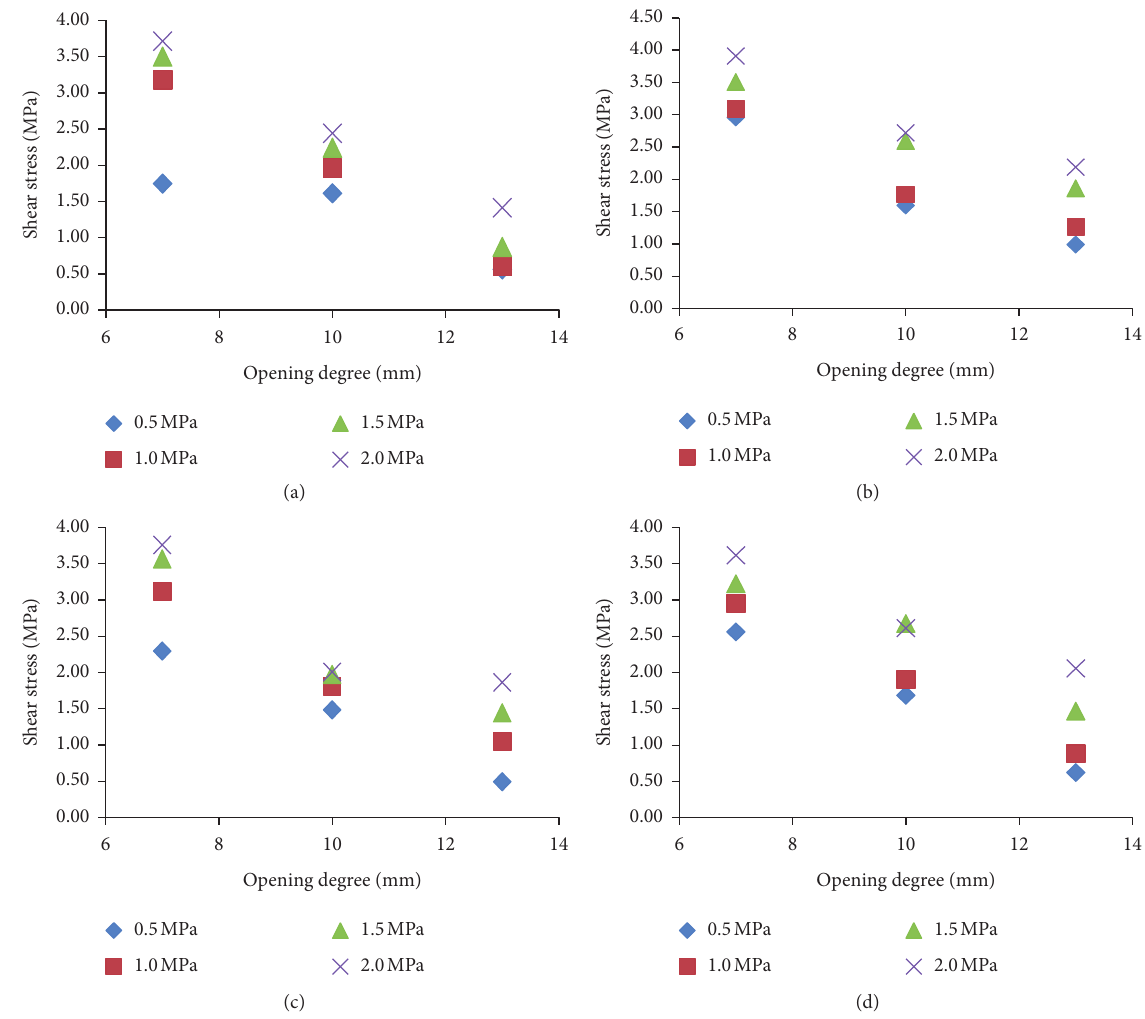
Figure 13: Evolution of peak shear strength of frozen joints under different conditions. (a) Specimen 1#. (b) Specimen 2#. (c) Specimen 3#. (d) Specimen